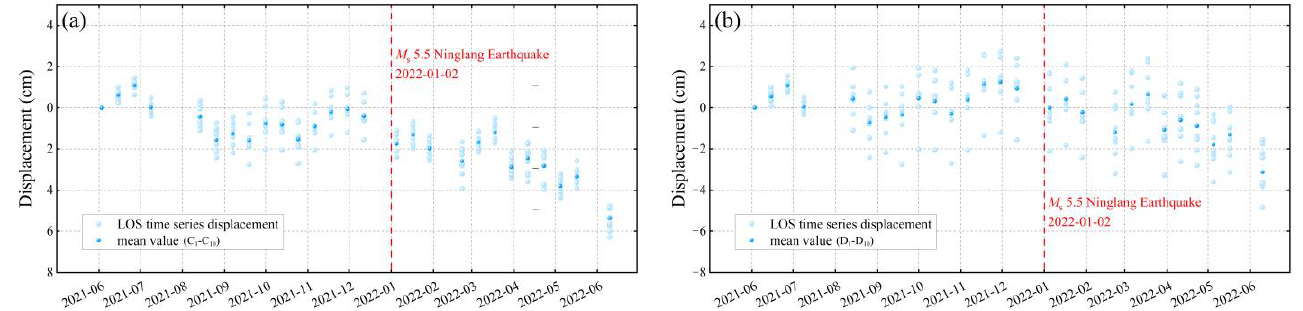
Figure 9. ( a ) The deformation time series at point C 1 to point C 10 ; ( b ) The deformation time series at point D 1 to point D 10 ;